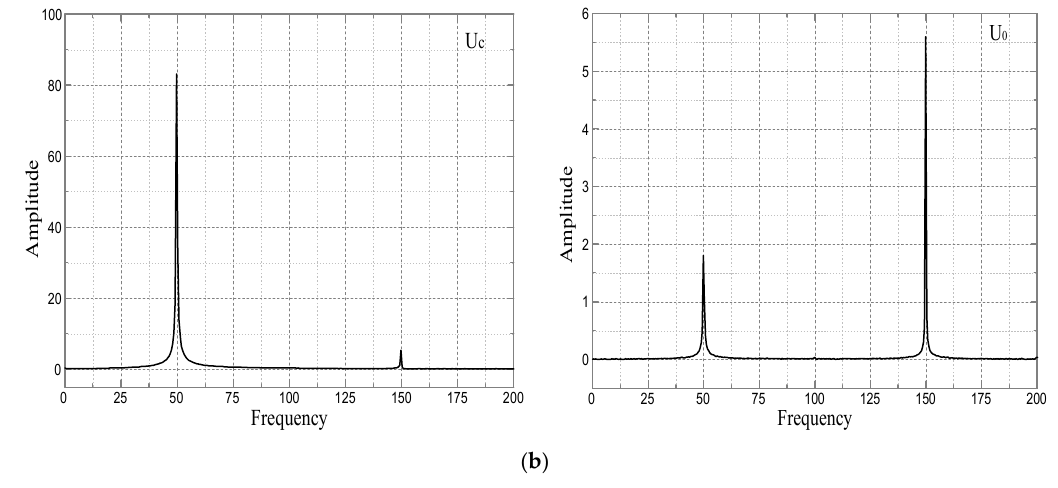
Figure 16. Amplitude of the frequency spectra of the phase voltages. ( a ) Before KM is closed. ( b ) after KM is opened.